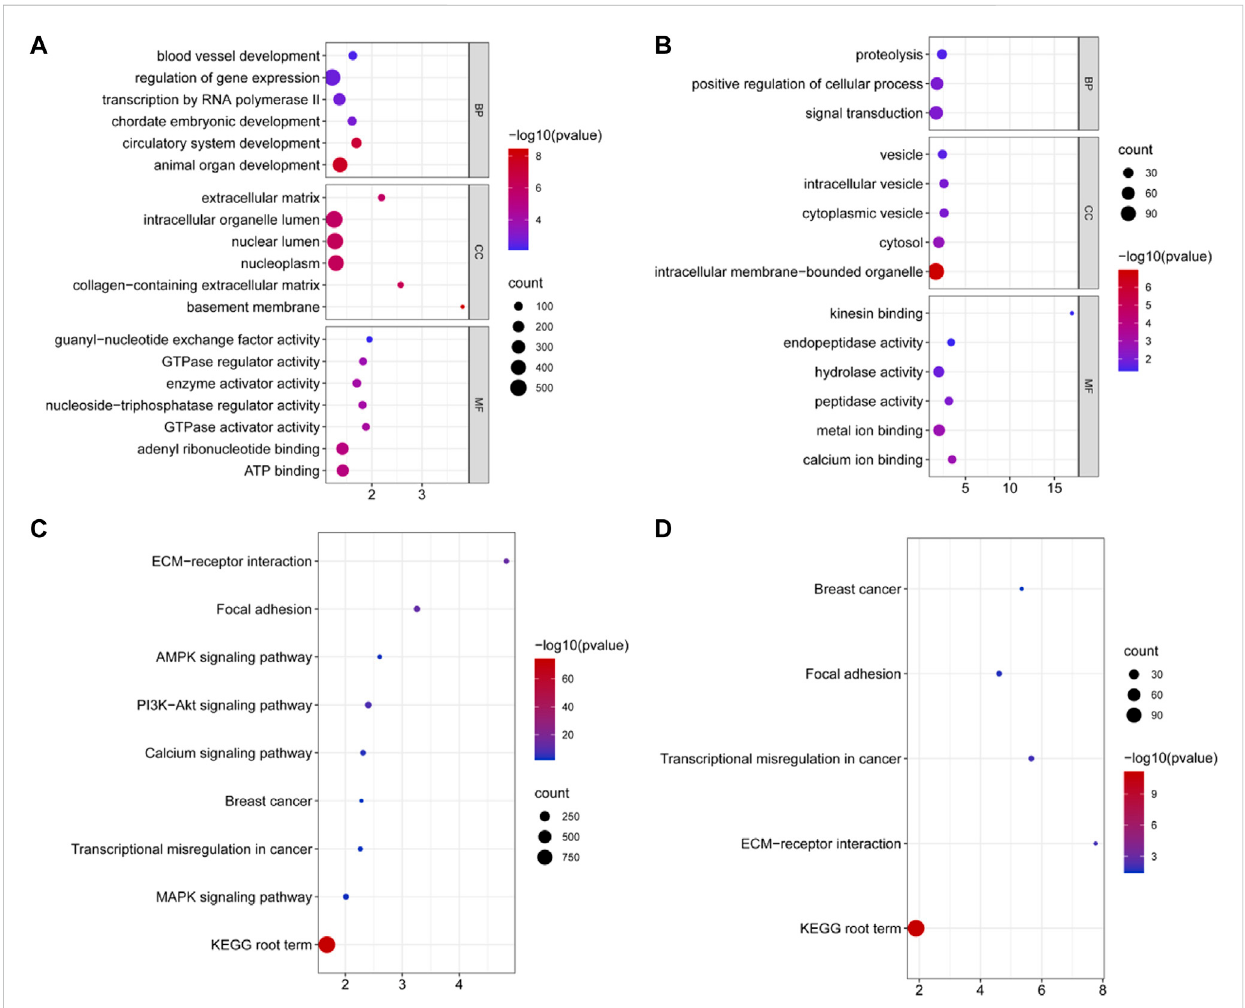
The volcano plots of all expressed miRNAs in the livers of Hu sheep (short/fat-tailed sheep) and Tibetan sheep (short/thin-tailed sheep). The x -axis denotes the values of log2 (fold-change), whereas the y -axis denotes the − log10 (padj). The colored dots represent the expressed miRNAs, with blue indicating downregulated miRNAs and red indicating upregulated miRNAs (padj ≤ 0.05). The black dots indicate that the miRNAs are not statistically signi fi cant (padj >